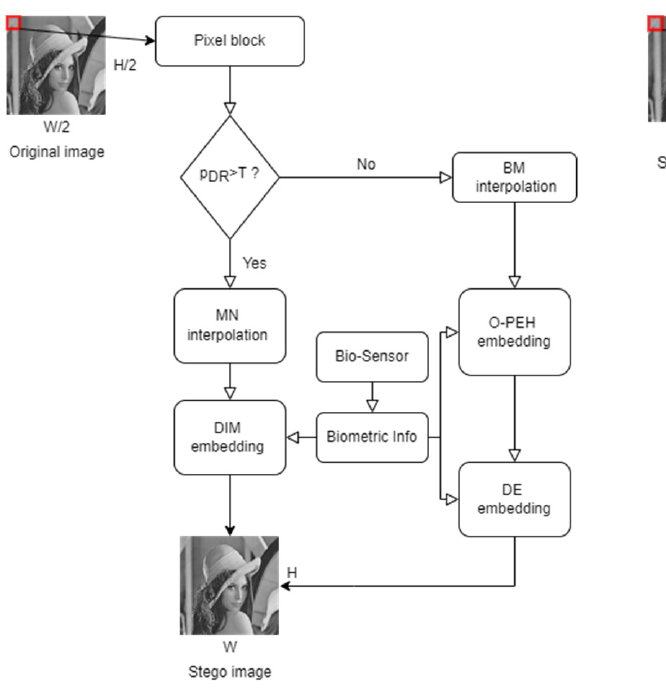
Figure 5. Flowcharts of the embedding and the extraction stages; ( a ) Flowchart of the embedding stage; ( b ) Flowchart of the extraction stage.